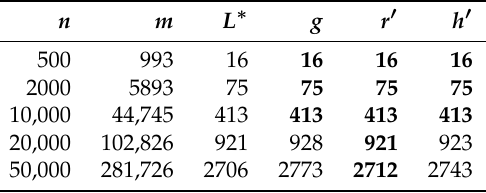
Table 10. Results for Pokec Graphs.